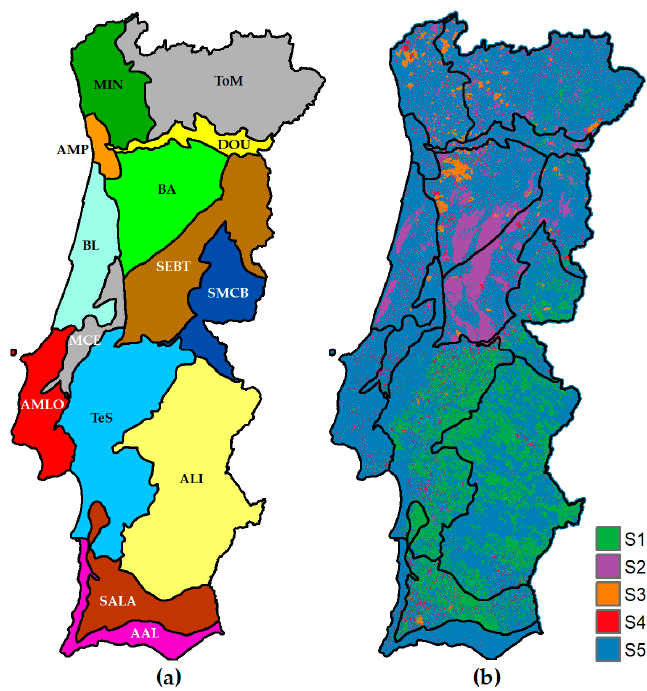
Figure 3. Spatial stratification: ( a ) mapping zones, identified by acronyms (not explained here for brevity), and ( b ) mapping subzones, which are forest and agro-forestry systems of evergreen oaks (S1), burnt area in 2017 (S2), burnt area in 2016 (S3), clear-cuts in forest and shrublands during 2015–2018 (S4), and the remaining area (S5).